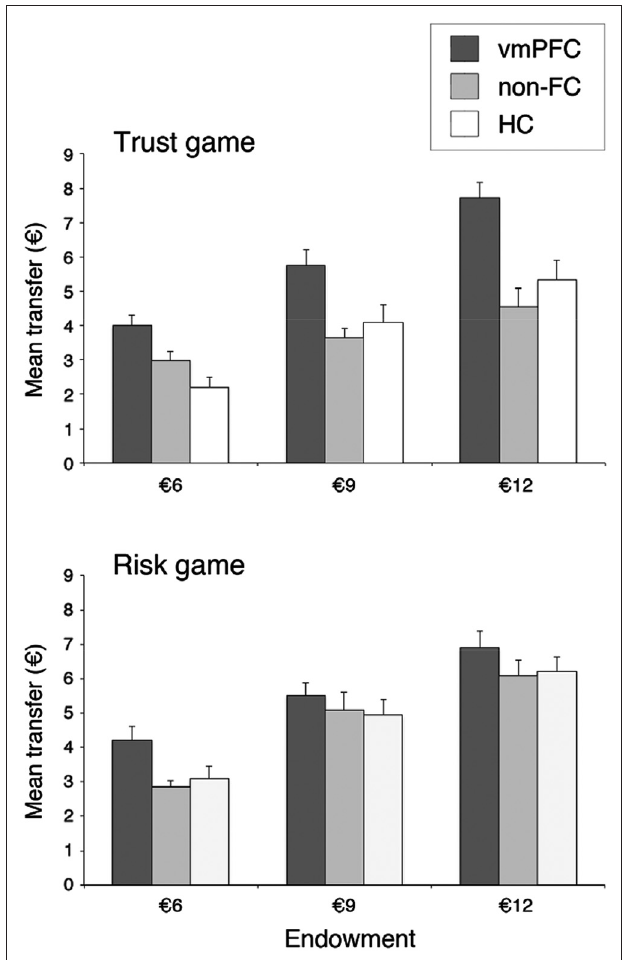
FIGURE 2 | Groups’ trust level, separately for trust game (upper panel) and risk game (lower panel), and endowment. Error bars indicate the SEM. vmPFC = ventromedial prefrontal cortex patients; non-FC = control patients; HC = healthy